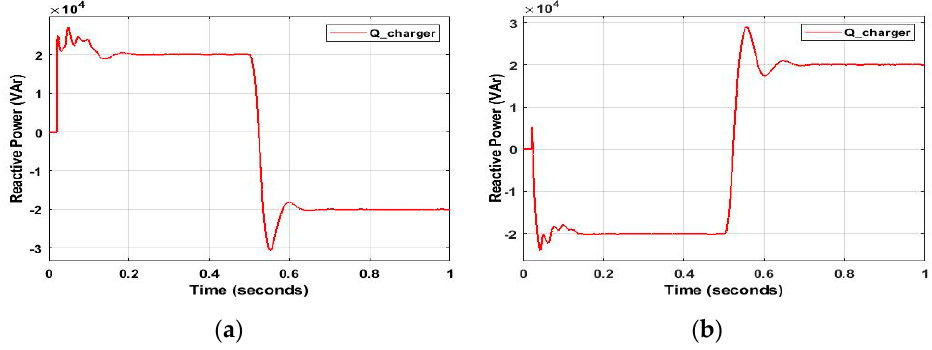
Figure 13. Charger’s response: ( a ) transition from inductive to capacitive operation and ( b ) transition from capacitive to inductive operation.